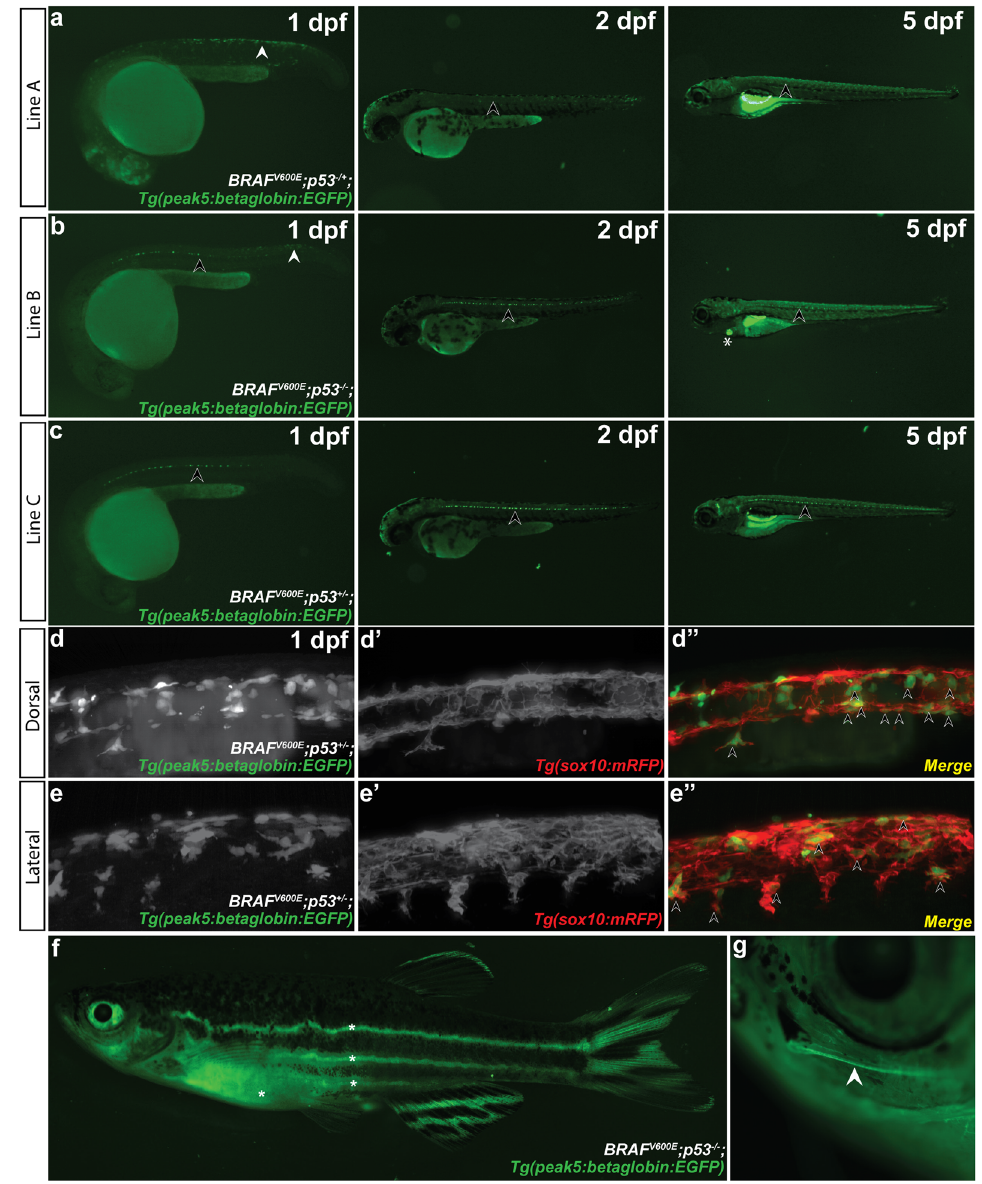
Fig. 2 peak5 stable transgenic lines exhibit similar expression patterns in subsets of NCCs and neural crest derivatives. Multiple transgenic lines derived from independent founder (F0) parental fi sh were established that transmit the peak5:betaglobin:EGFP reporter through the germline. White arrowheads indicate NCCs. Black arrowheads point to KA neurons. Asterisks indicate heart EGFP localization in the heart. a Stable line A exhibits strong EGFP localization in NCCs at 1 dpf. At 2 dpf, some NCCs are labeled, and KA neurons are also faintly visible. At 5 dpf, the most prominently labeled cells are KA neurons and cells near or within the swim bladder. b At 1 dpf, Line B exhibits EGFP localization in posterior premigratory NCCs and strong localization in KA neurons. By 3 and 5 dpf, EGFP localization is primarily within KA neurons and the heart. c Line C mainly exhibits EGFP localization in KA neurons at 1, 2, and 3 dpf. d Lightsheet microscopy of the dorsal aspect of peak5:betaglobin:EGFP Line A embryos shows peak5 is active in cells with NCC morphology and premigratory NCC localization at 1 dpf and d ′ – d ″ co-labels with Tg(sox10(7.2):mRFP) positive cells. Arrowheads point to representative co-labeled cells. The lateral aspect also shows e – e ″ EGFP positive cells that co-localize with mRFP positive cells. Arrowheads point to representative co-labeled cells. f Whole animal image of peak5 active in stable transgenic line A. Asterisks (*) indicate regions of auto- fl uorescence; a long pass fi lter set allows discrimination between the yellow hue of auto fl uorescent tissue and EGFP -expressing cells. g EGFP positive cells peripheral nervous system cells within the barbel activity in melanoma. As predicted, the sox10 minimal promoter animals from 1 stable line; n = 1/26 EGFP positive tumors in 25 drove EGFP expression in melanoma patches and tumors across peak8 transgenic animals from three independent stable lines) 6 stable lines ( n = 38/46 EGFP positive tumors in 42 animals) (Supplementary Fig. 5d-g ′ ; Table 1). These peak1 and peak8 data (Supplementary Fig. 5a-c ′ ; Supplementary Table 1). Unlike peak5 serve as negative controls to highlight the speci fi city of peak5 transgenic lines, peak1 and peak8 stable lines expressed EGFP from within the sox10 super-enhancer and demonstrate that not embryonically but did not express EGFP in nearly all melanoma all sub-elements that drive EGFP embryonically are suf fi cient to tumors ( n = 0/6 EGFP positive tumors in 6 peak1 transgenic drive EGFP expression in melanoma. These data also show that